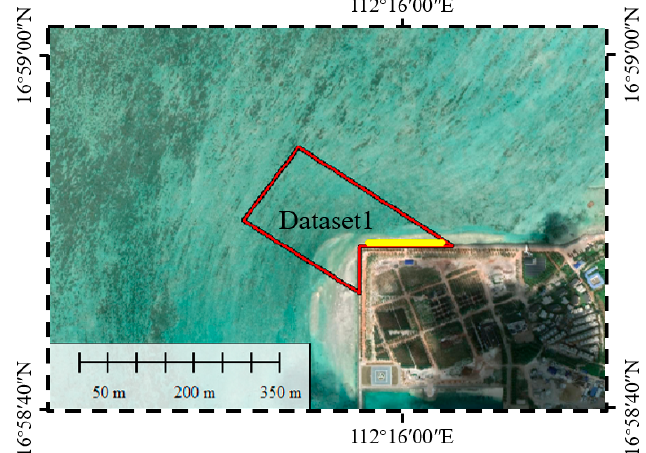
Figure 13. The scope of Dataset 1 (red line) and the selected profile (yellow line).